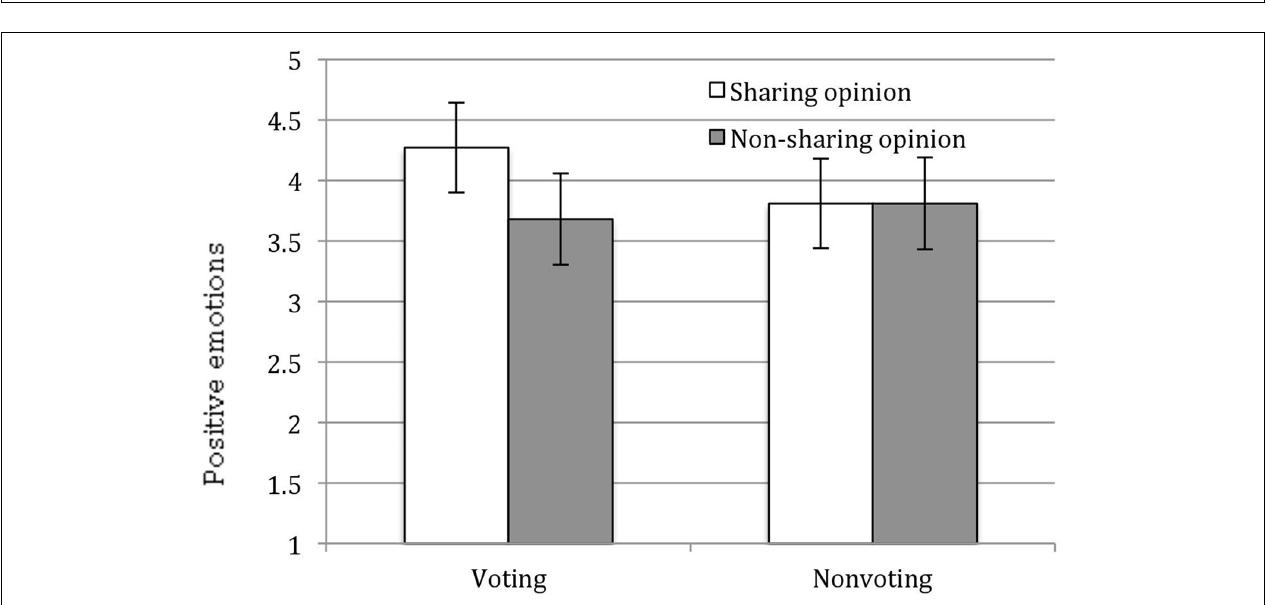
FIGURE 1 | Effect of voting or without voting and opinion sharing and without sharing on outgroup tolerance toward mental patients, controlling gender and age (Study 2). Error bars represent 95% confidence intervals.